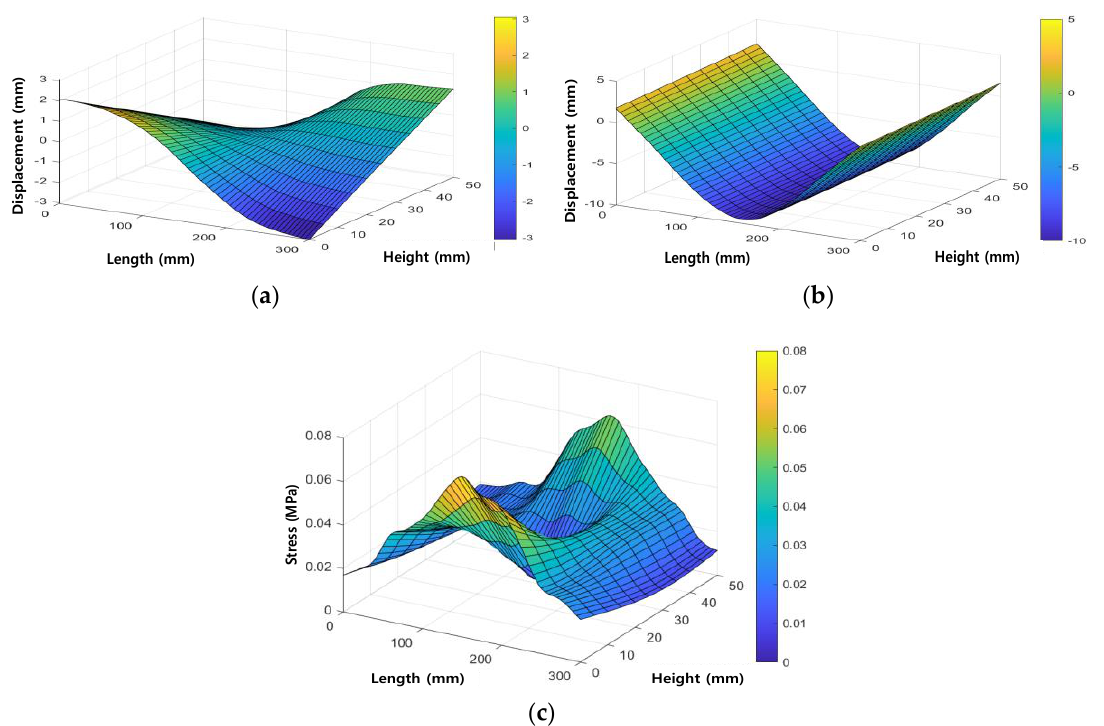
Figure 23. Surface plots obtained by the synthetic structural analysis: ( a ) x-direction displacement, ( b ) y-direction displacement, and ( c ) von Mises stress using expanded TP.